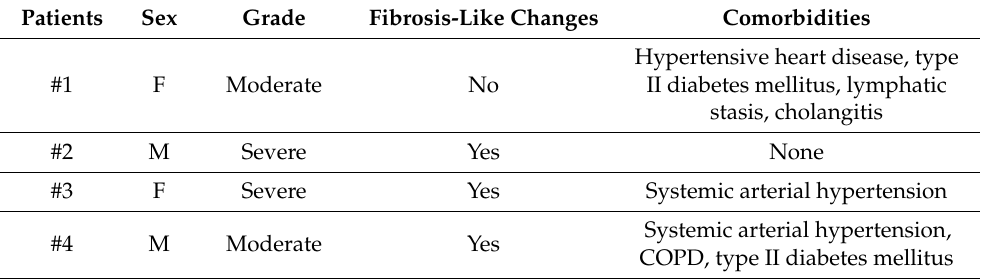
Table 1. Characteristic of post-COVID-19 (PC)